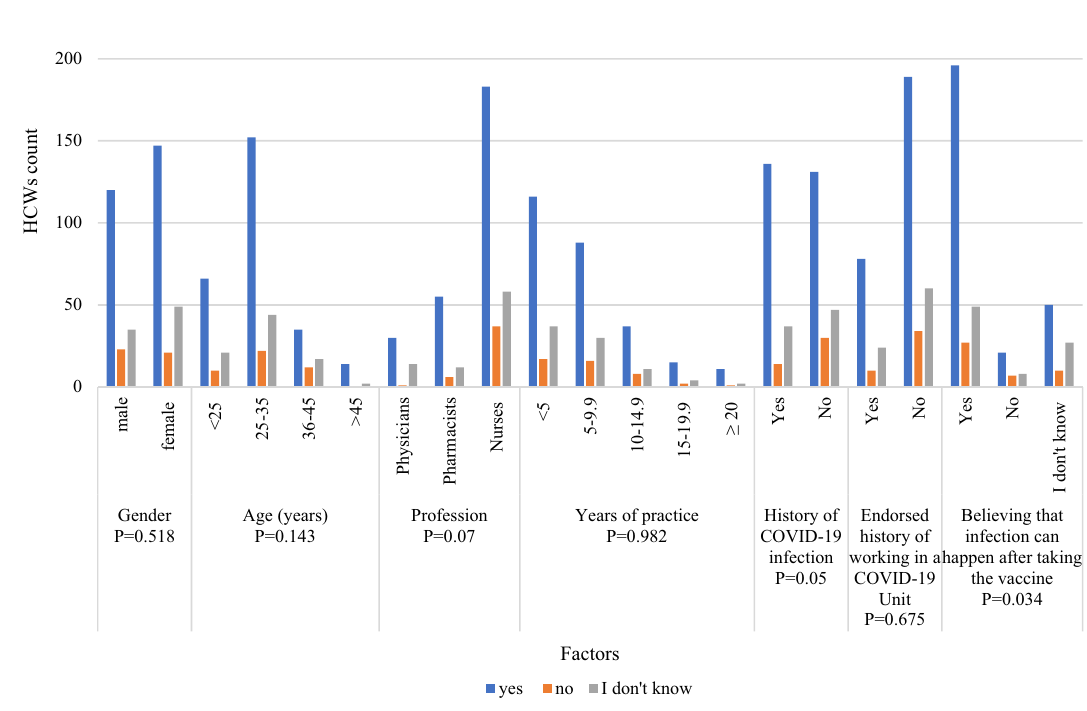
Figure 1. Factors affecting vaccination acceptance among HCWs.